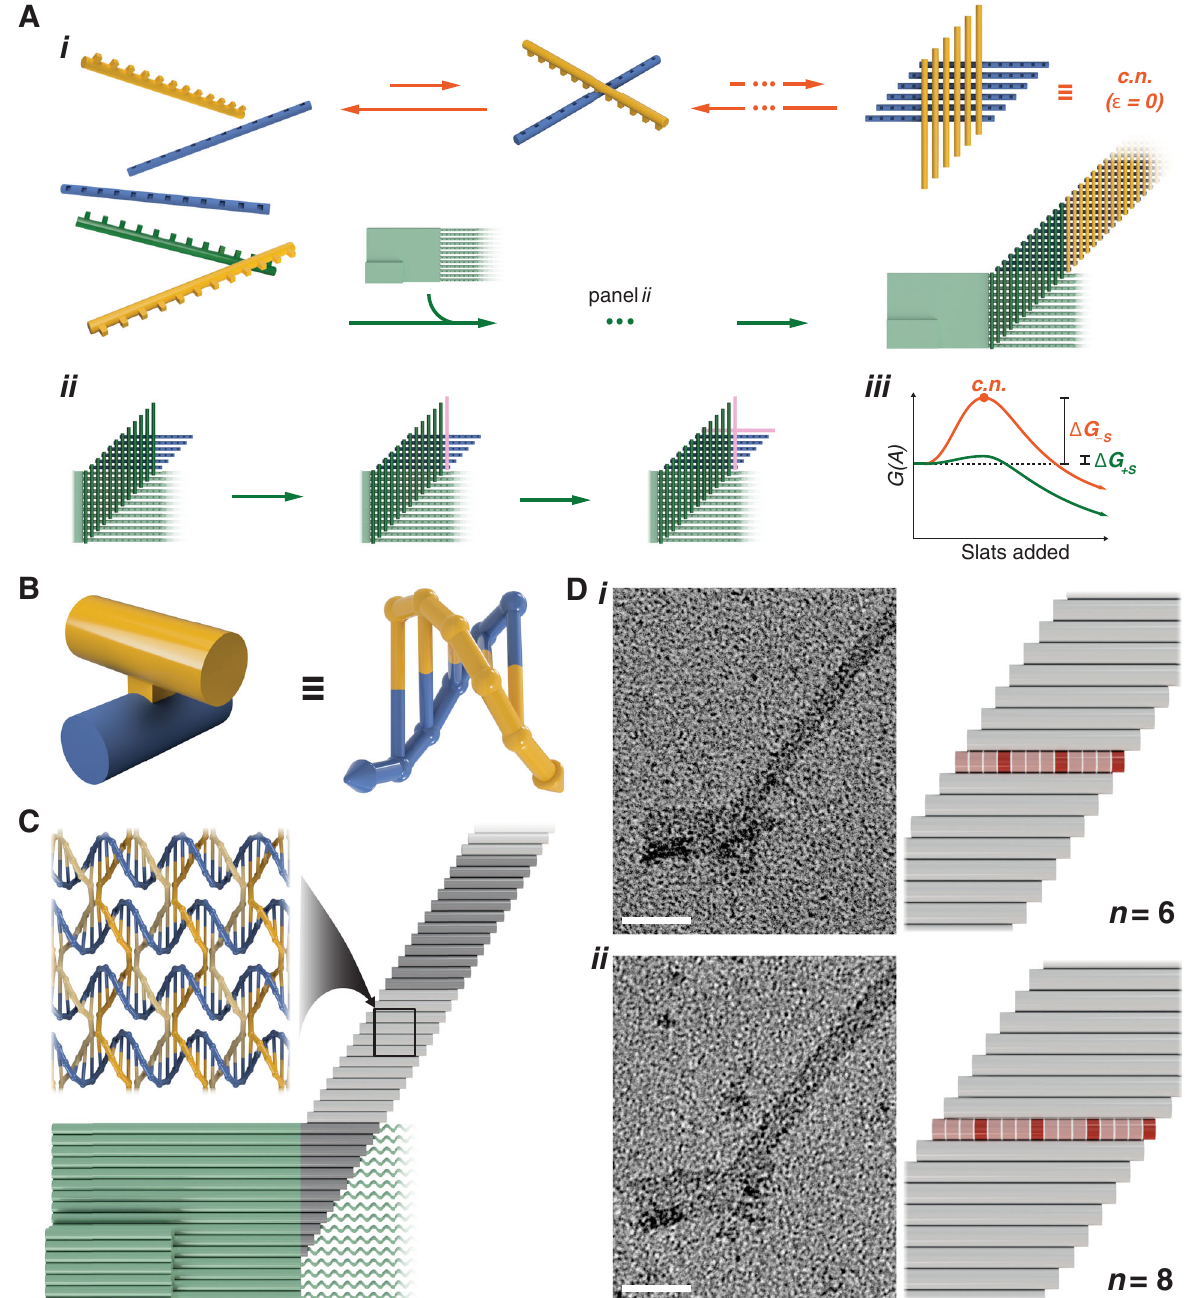
Fig. 2 Crisscross polymerization as implemented with ssDNA slats. A i Ribbon assembly of abstract v6 x-slats (blue) and y-slats (gold). Upper pathway shows transient association of free slats, where the critical nucleus (c.n.) requires a multitude of unfavorable slat additions. Lower pathway uses a seed (light green) to capture twelve nuc- y -slats (dark green) along with six x -slats. A ii, Subsequent slats (magenta) are recruited in alternating perpendicular fashion for ribbon growth. A iii, Qualitative energy landscape for unseeded (orange) versus seeded (green) nucleation and growth of slats using irreversible growth conditions. B Each binding domain in the abstract model is a half turn of DNA. C Crisscross polymerization of ssDNA slats (blue x - and gold y -slats) as triggered by a DNA-origami seed (light green). Straight cylinders represent double helices. D Left are negative-stain TEM images of v6 ( n = 6) and v8 ( n = 8) ribbons, in (i) and (ii), respectively. Right models show width differences, where each boxed cell is a single half-turn domain. Light-red or dark-red cells correspond to either fi ve or six base-pair domains. Scale bars are 50 migrating band on an agarose gel with respect to the origami seed formed ribbons optimally at 44 – 50 °C, whereas v8 slats grew “ S ” band (e.g., the orange boxed band in Fig. 3C). We also observe optimally at temperatures 48 – 54 °C. Monodispersity and total a minor population of a more slowly migrating species (i.e., higher lengths of ribbons at a given condition differed among sequence on the gel) that resemble entangled ribbons after excision from the variants, such as v6.1 and v6.3, which generally grew longer and gel and imaging via TEM. The v6 slats in 12, 14, or 16 mM MgCl 2 more evenly than v6.2 (Supplementary Table 2). The copy number